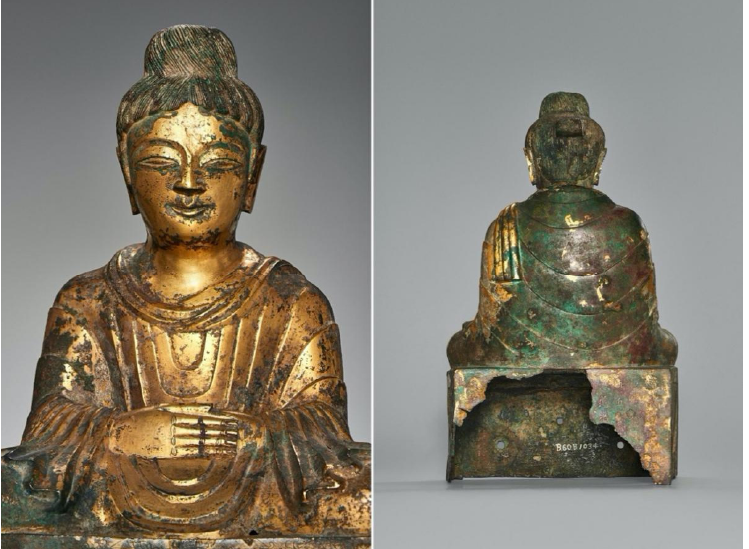
Figure 5. Gilded bronze Buddha from the Later Zhao Dynasty. Materials: gilt bronze. Dimensions: H. 39.7 cm × W. 24.1 cm × D. 13.3 cm. Displayed in the Asian Art Museum of San Francisco, San